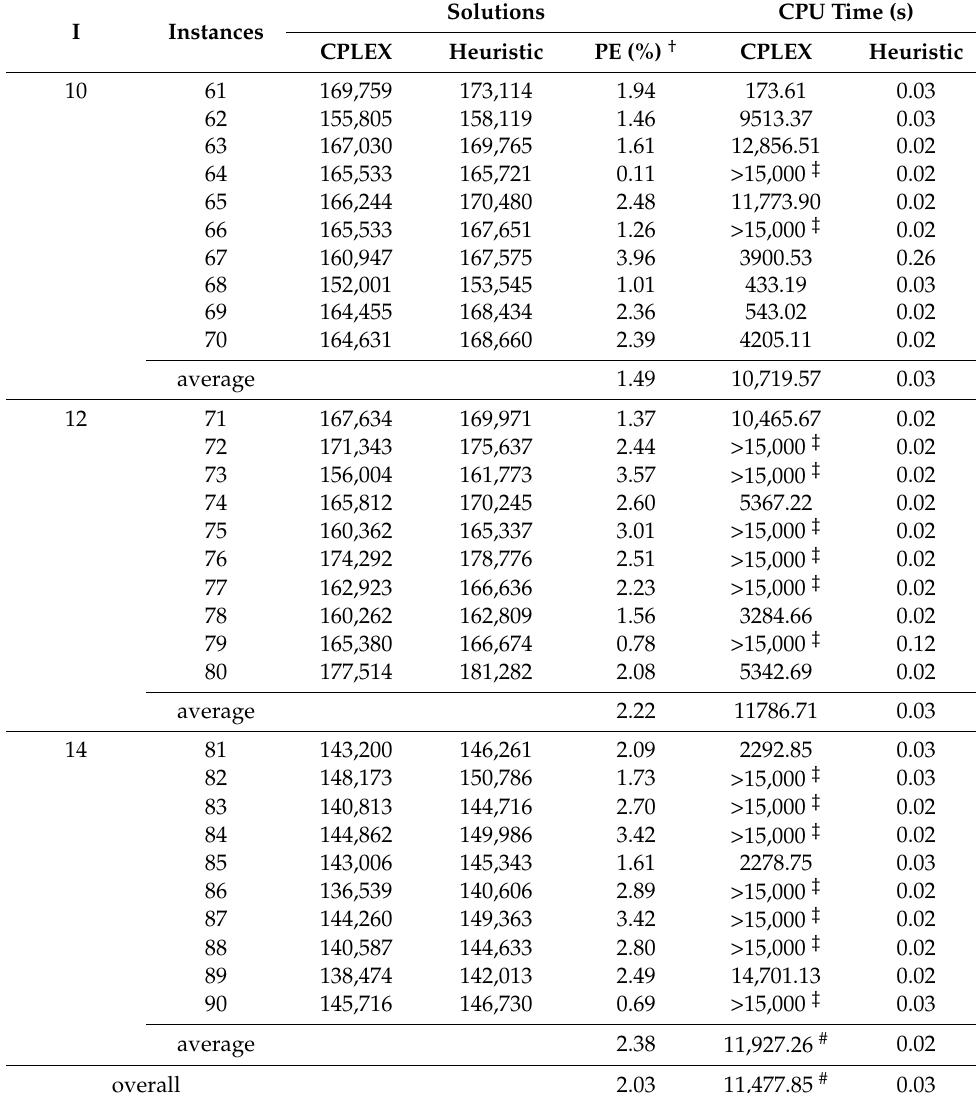
Table 3. Results of the test on 10-period